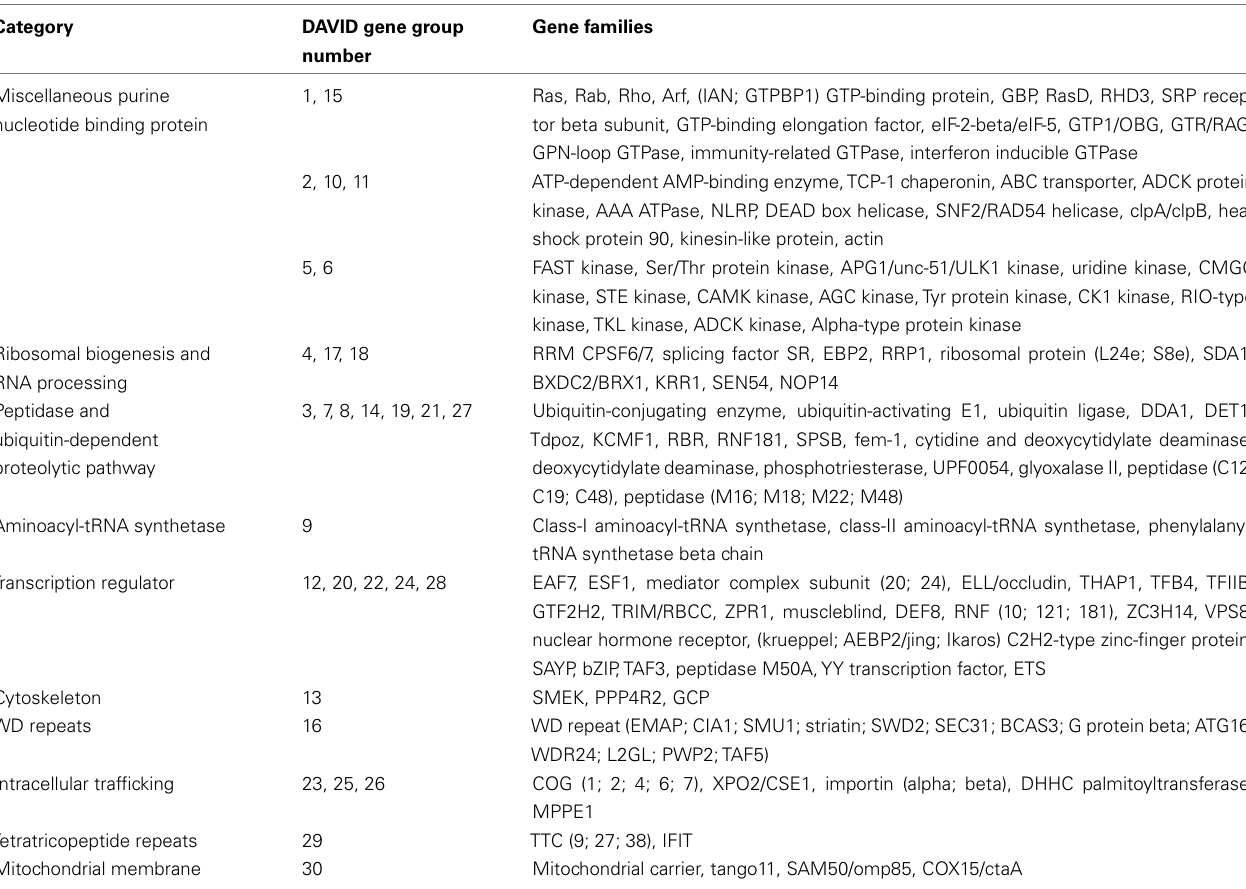
Table 1 | Gene families of up-regulated genes in 4-day hyperglycemic MBL null mice compared toWT control.